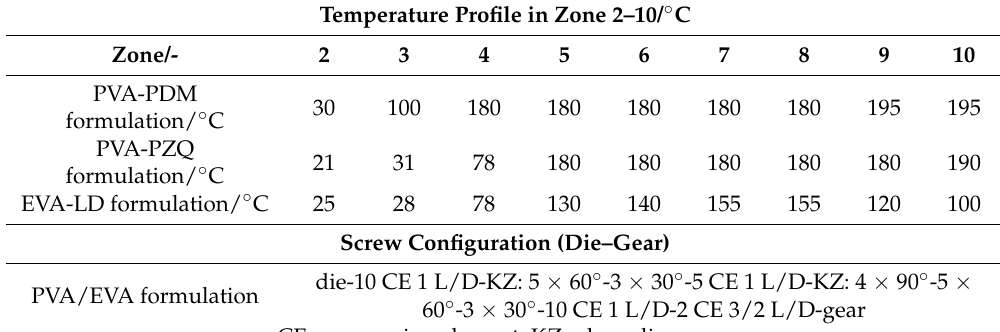
Table 1. Extrusion settings (temperature profile and screw configuration) for the used